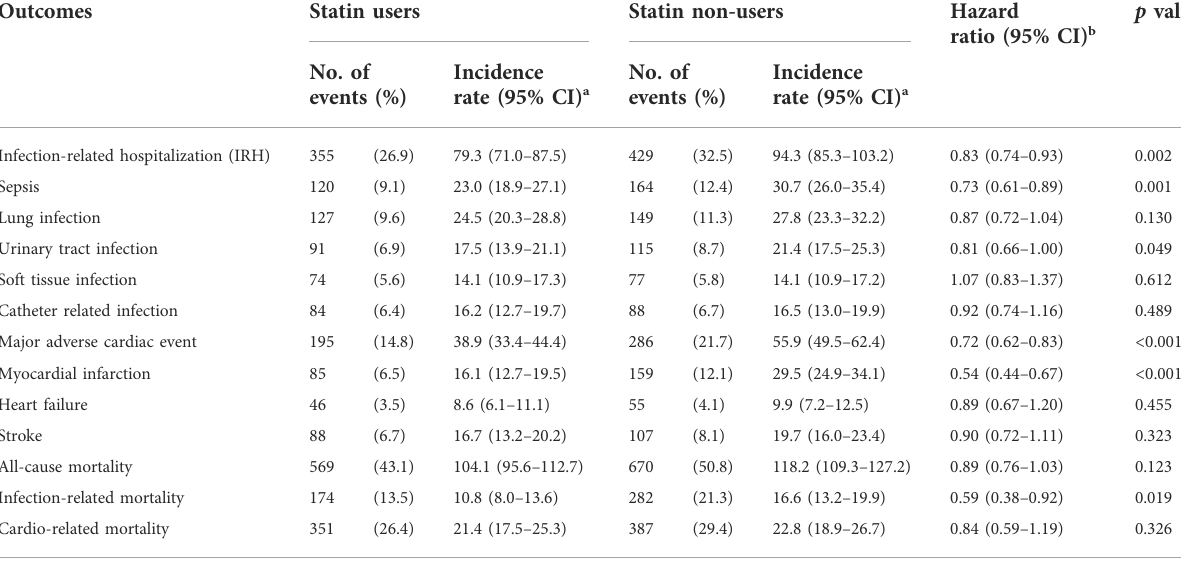
TABLE 2 Event numbers and hazard ratios of the primary outcomes between statin users and statin non-users.